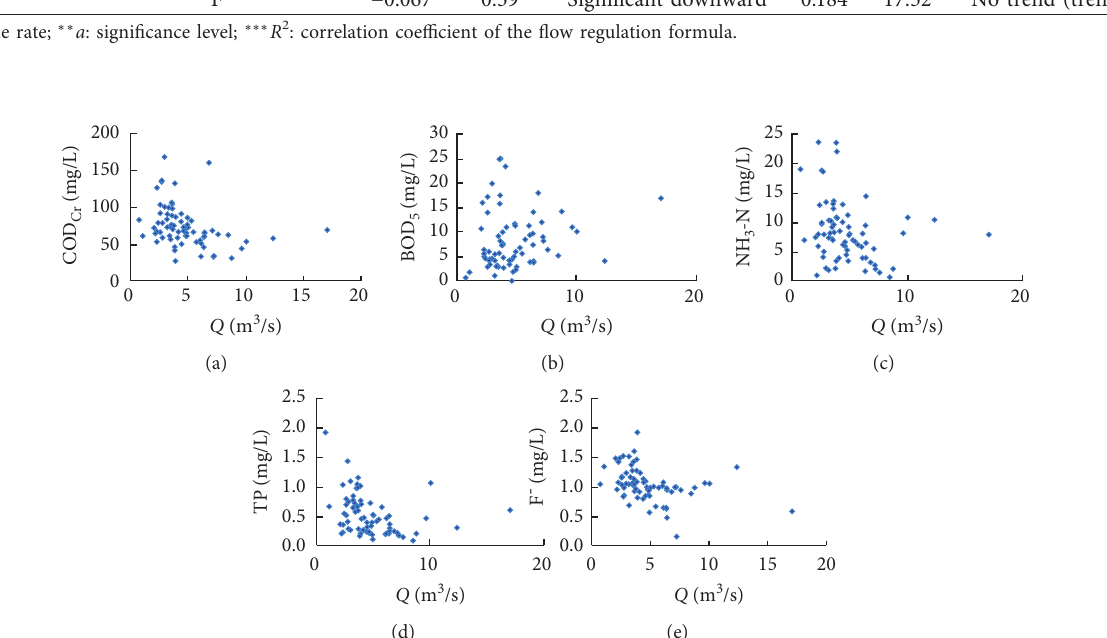
− Cr ; (b) BOD 5 ; (c) NH 3 –N; (d) TP; (e) F